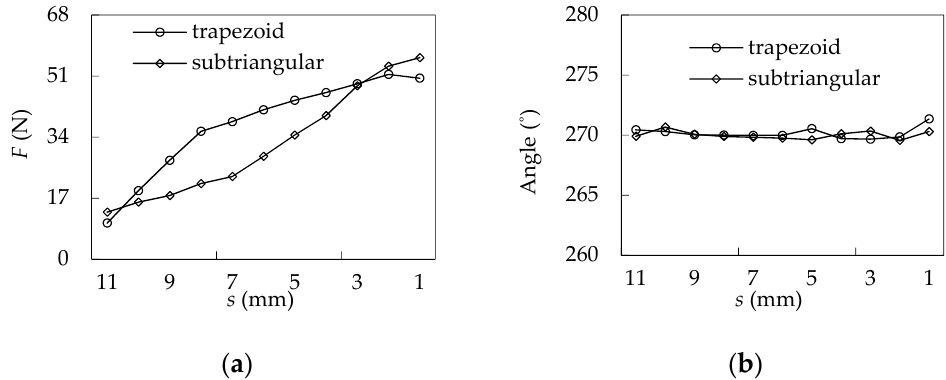
Figure 15. The influence of the NMC shape on EF (in the centerline): ( a ) the amplitude curve; ( b ) the phase curve.